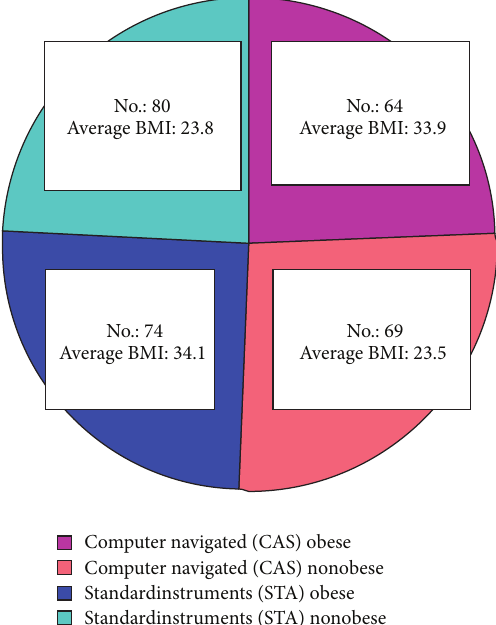
Figure 1: Distribution of TKR as per BMI (obesity) and operative